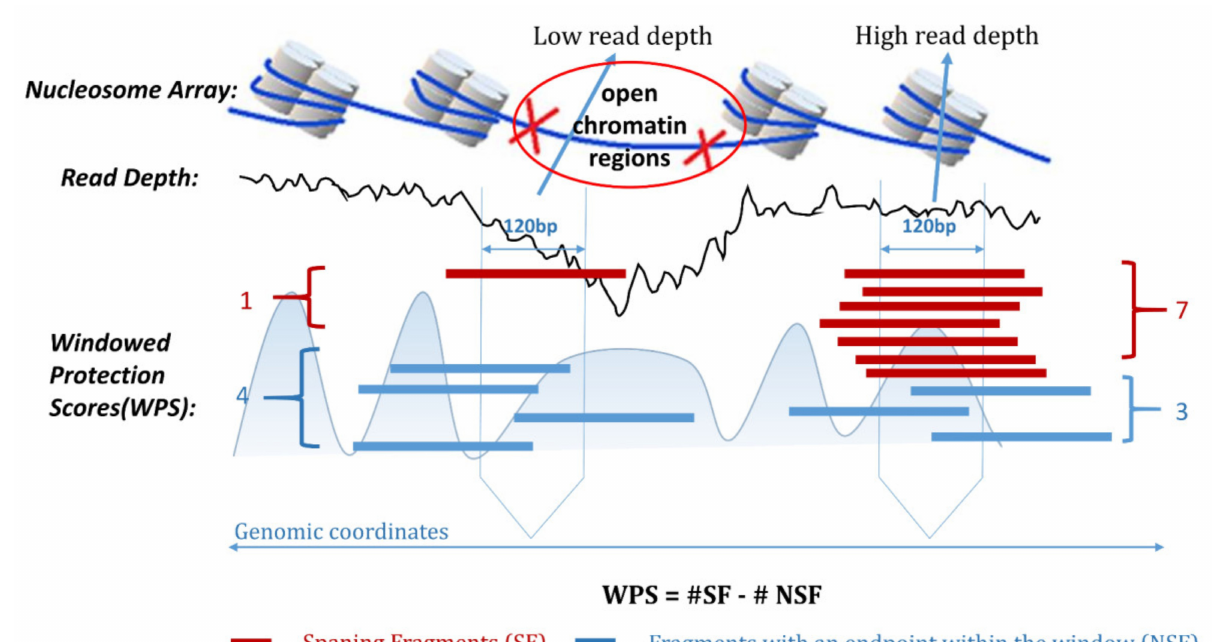
Figure 1. The cfDNA-seq coverage of the OCRs and the characteristics of the calculated WPS waveforms. There are more cfDNA fragments across the window and fewer fragments with an endpoint within the same window. In the OCRs, DNA is not protected by nucleosomes, so it is fragmented and cannot be effectively sequenced. Fewer cfDNA fragments span the window, more fragments fall into the window, and the coverage of cfDNA in this window region is